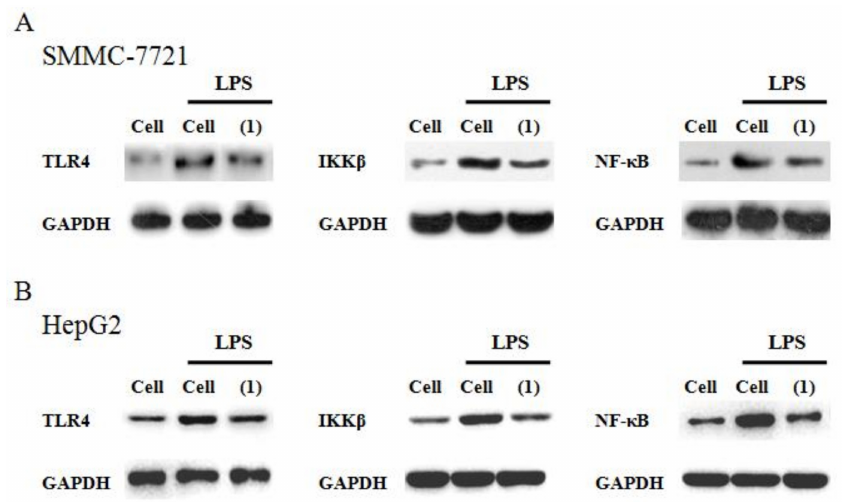
Figure 7. Effect of 200 µ M castanol B (1) on theexpression of proteins TLR4, IKK β , and NF- κ B p65 in lipopolysaccharide(LPS)-induced SMMC-7721 cells ( A ) and HepG2 cells ( B